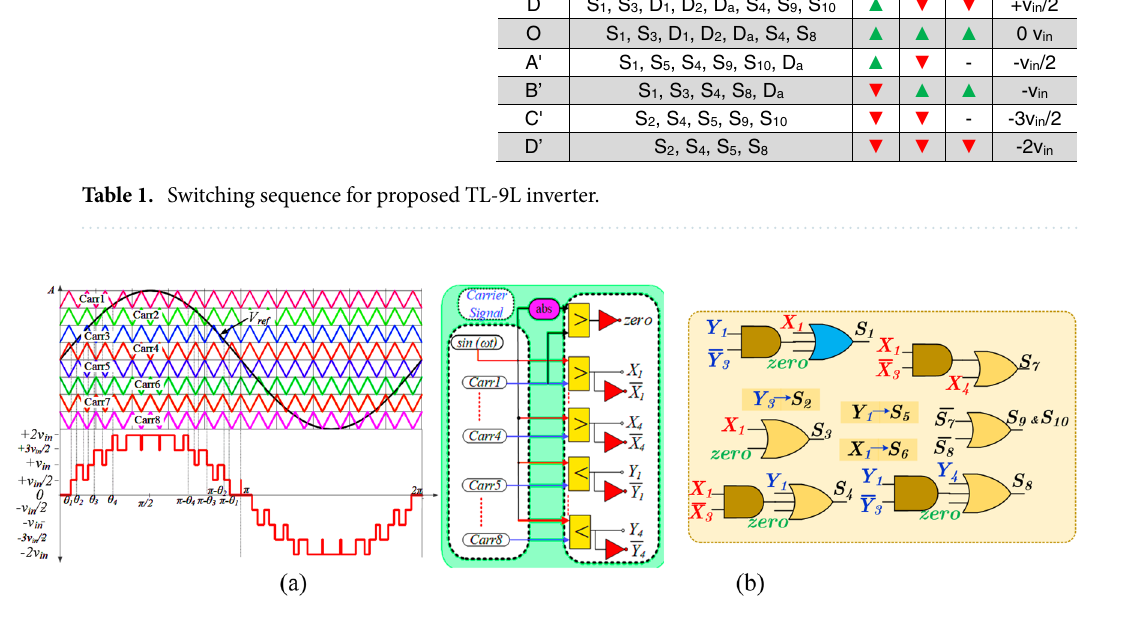
Figure 3. ( a ) Typical 9L output voltage waveform ( a ) sinusoidal PWM for 9L inverter and ( b ) PWM